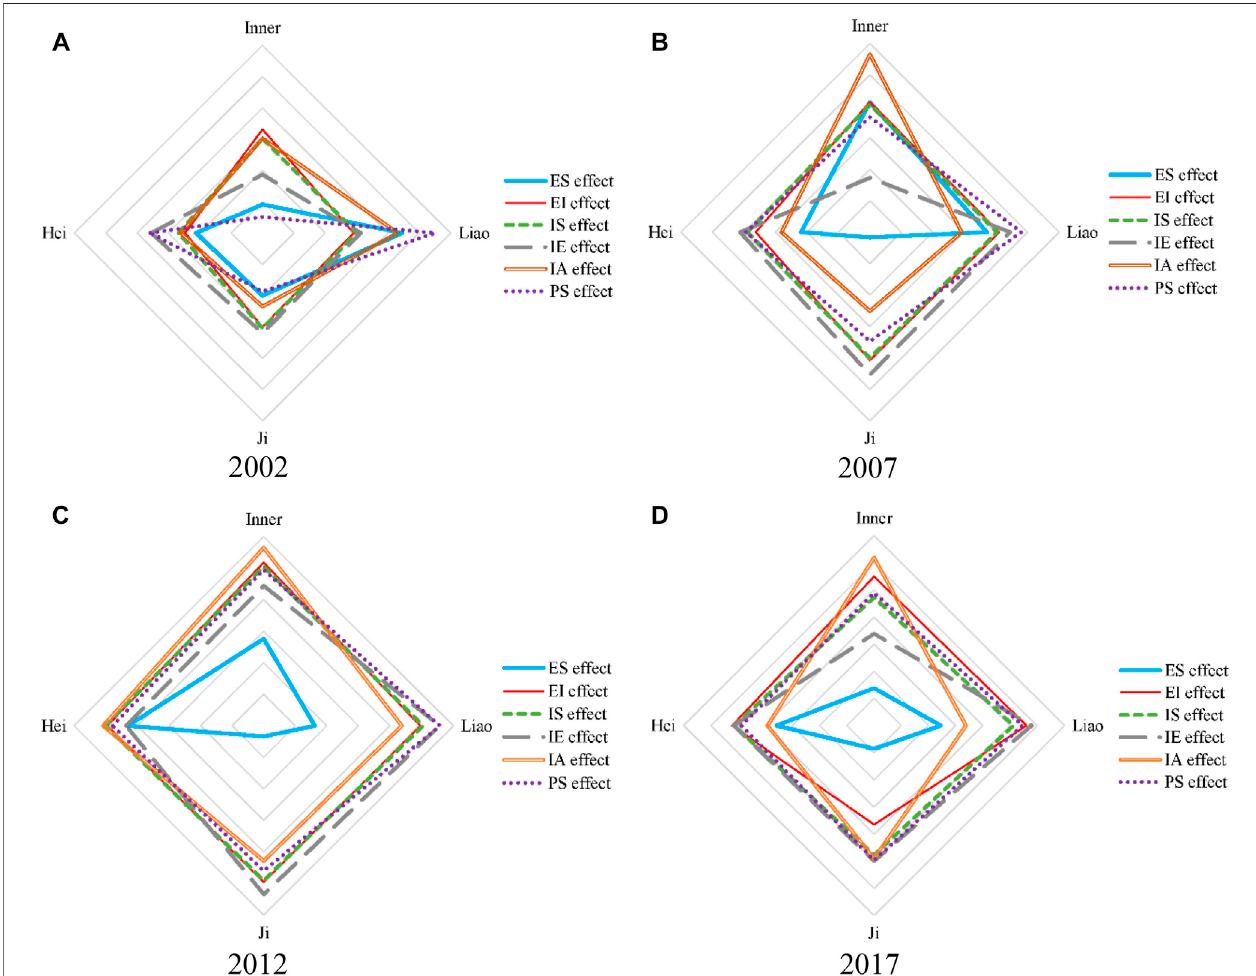
FIGURE 6 | Spatial decomposition results for the four northeastern regions in (A) 2002, (B) 2007, (C) 2012, and (D) 2017.